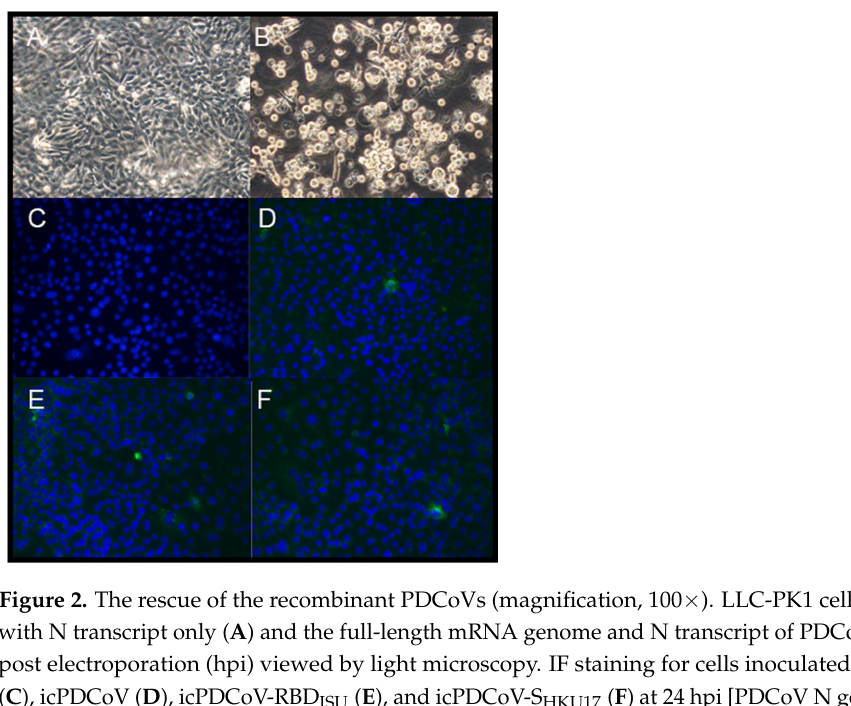
(Figure 2). The replication of recombinant viruses was assessed by multistep growth ki- netics at a MOI of 0.01. Though all three recombinant viruses replicated at a similar rate at the early phase [within 16 h post-inoculation (hpi)], much lower peak infectious titers were observed for icPDCoV-S HKU17 and icPDCoV-RBD ISU mutants (Figure 3A). In sum- mary, those two chimeric viruses showed less efficient replication compared with icPD- CoV in LLC-PK1 cells.